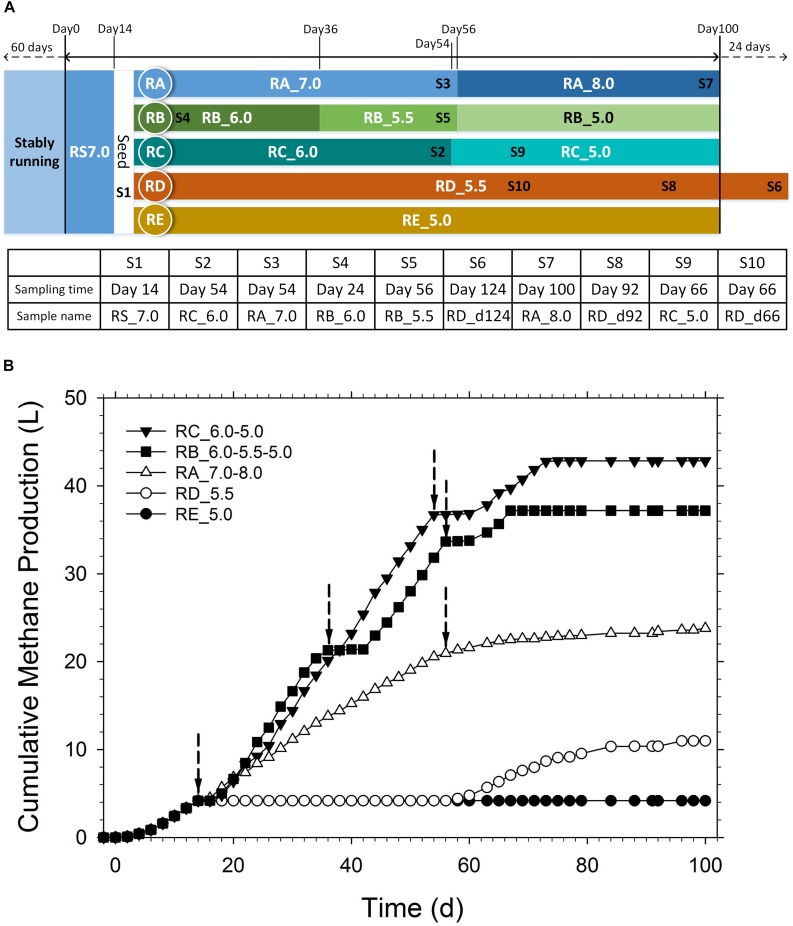
(A) Diagram of the pH regulation schedule and biomass sampling points. (B) Cumulative methane production under different pH values during the operation period. The arrows indicate the time points for pH adjustment.